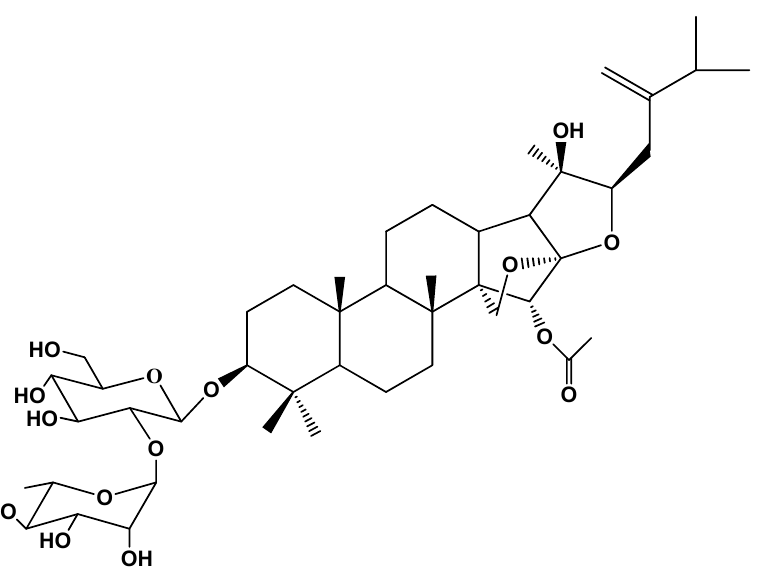
Figure 4. Chemical structure of ampelozizyphoside A.